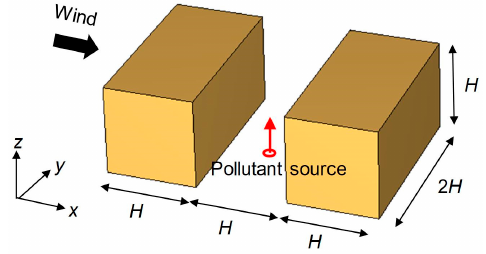
Figure 11. Wind tunnel test performed by Tominaga and Stathopoulos [37].